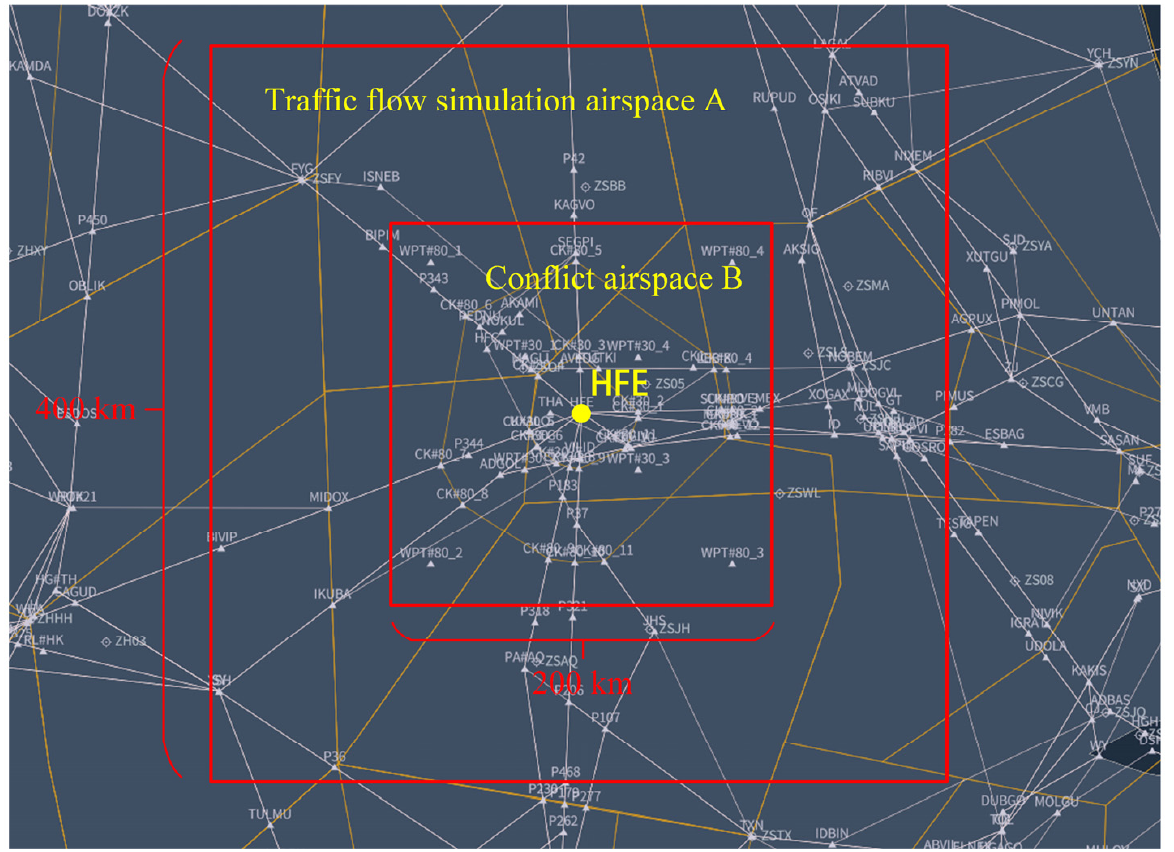
Figure 8. Traffic simulation and conflict airspace.